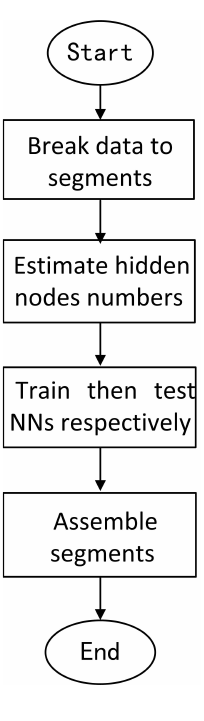
Figure 2. The algorithm